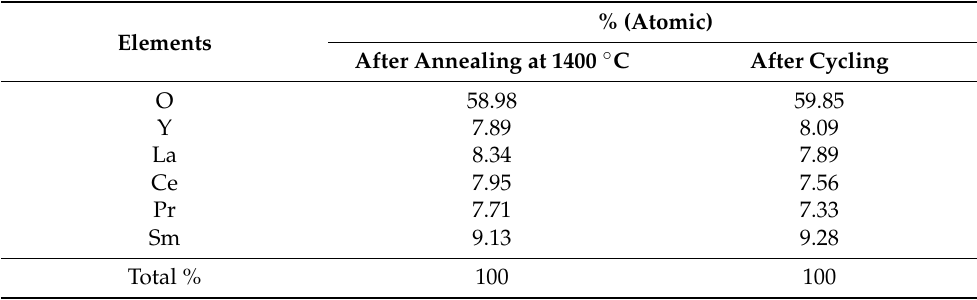
Table 3. Elemental composition of HEO 3 measured by EDS.